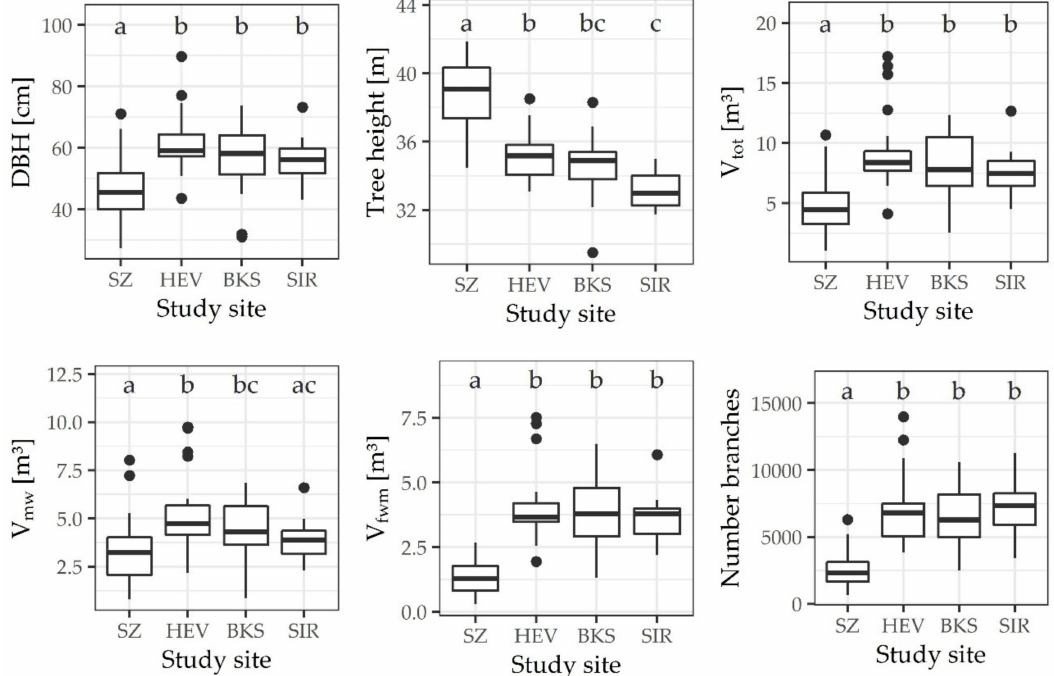
Figure 3. Variation in tree metrics between the stands along the management gradient. Different letters indicate significant differences (Tukey-HSD, p < 0.03) between study sites. DBH = diameter at breast height, V tot = total wood volume, V mw = merchantable wood volume, V fwm = volume of fine woody material. SZ = Schattiner Zuschlag (long-term unmanaged), HEV = Hevenbruch (short-term unmanaged), BKS = Berkenstrücken (extensively managed), SIR = Sirksfelder Zuschlag (intensively